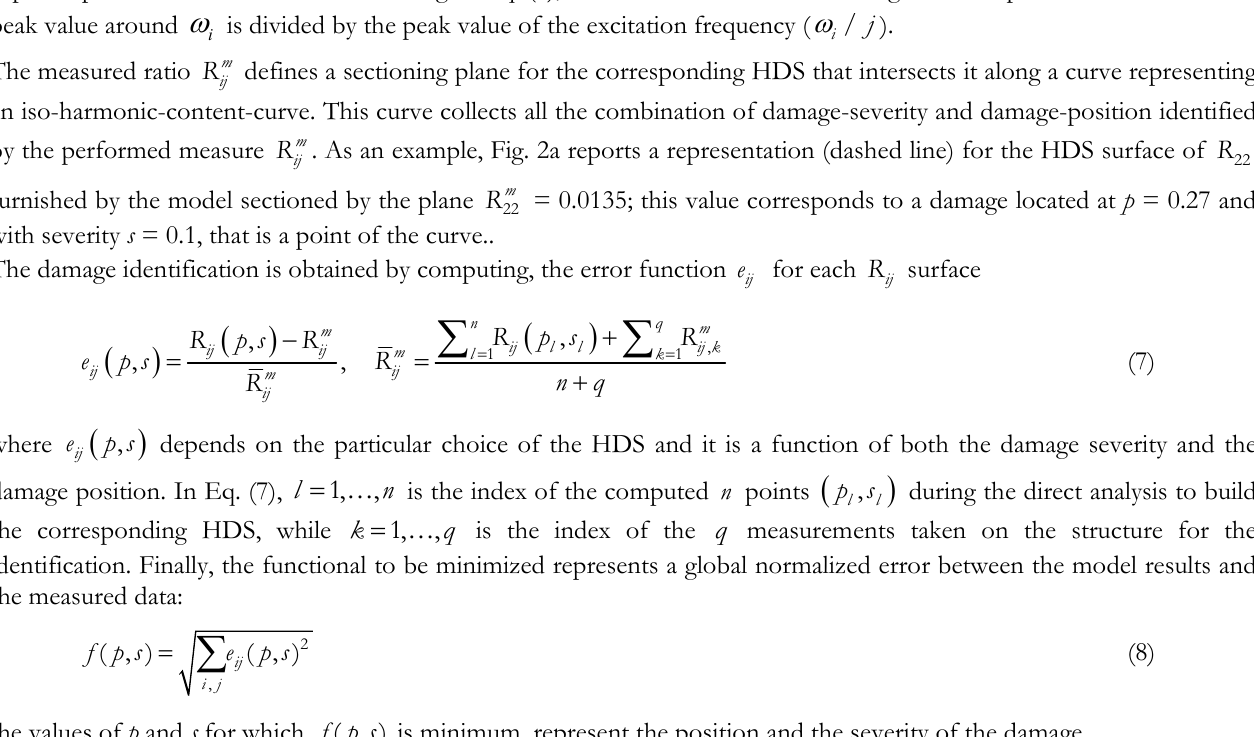
2 2  /2; a) l l ; b)  . l l 3 F 3 5 F